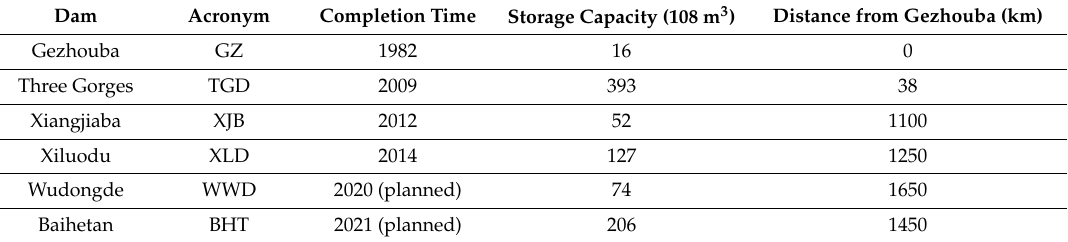
Figure 1. Locations of the dams in the Yangtze River. (GZ: Gezhouba, TGD: Three Gorges, XJB: Xiangjiaba, XLD: Xiluodu, BHT: Baihetan, and WDD: Wudongde). Table 1. The main characteristics of the six dams of interest and their corresponding